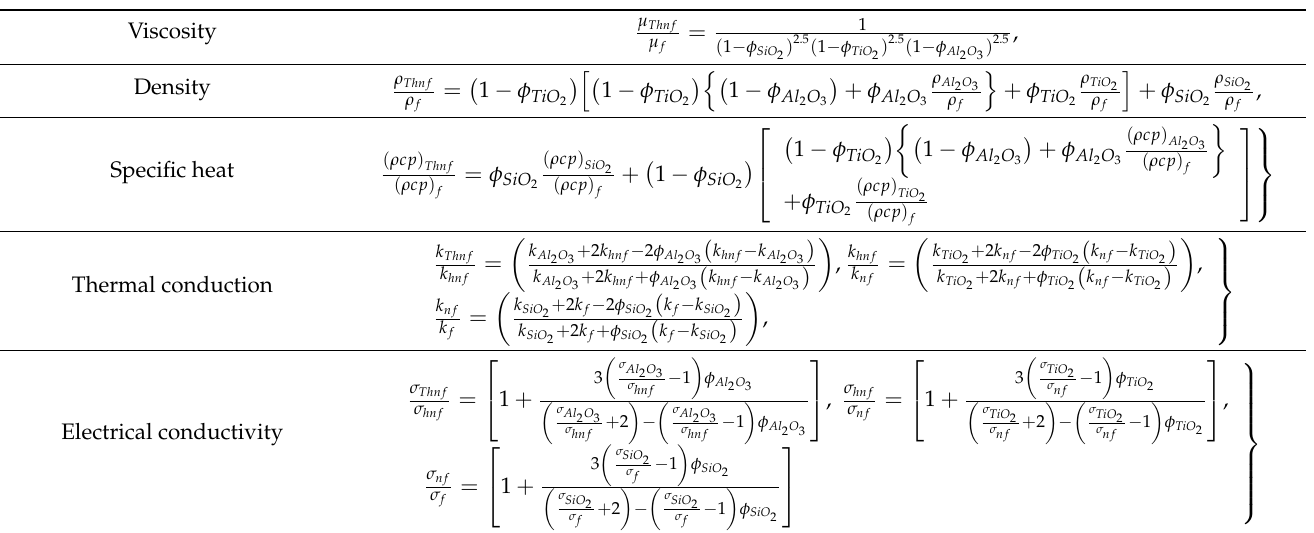
Table 2. The physical model for ternary hybrid nanofluid [23].